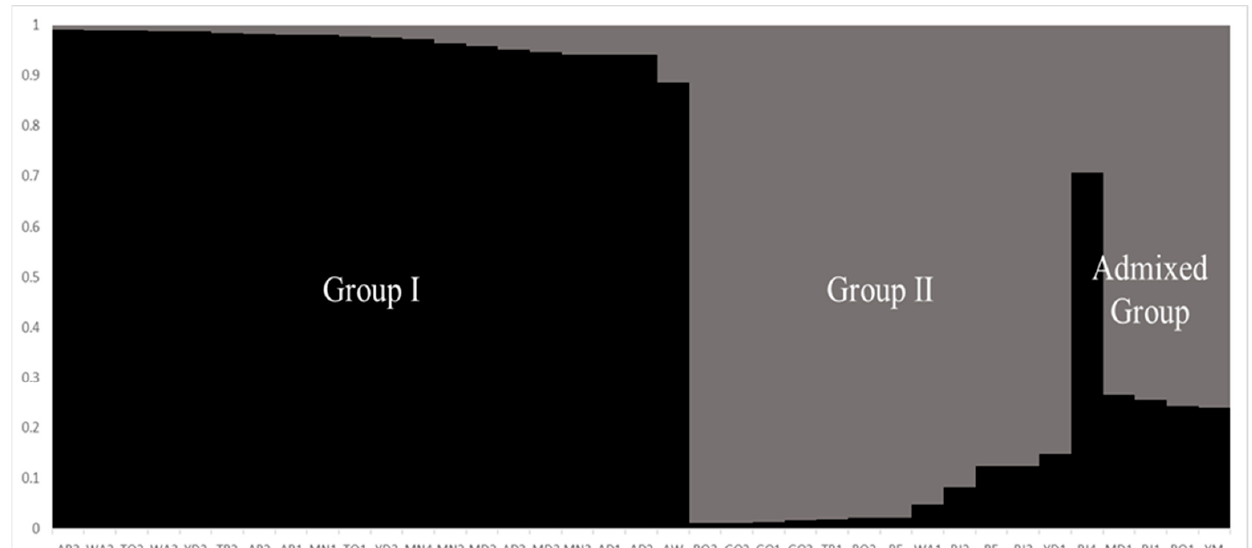
Figure 3. The population structure pattern for the highest Δ K value, K = 2, of the 37 maize landrace accessions.